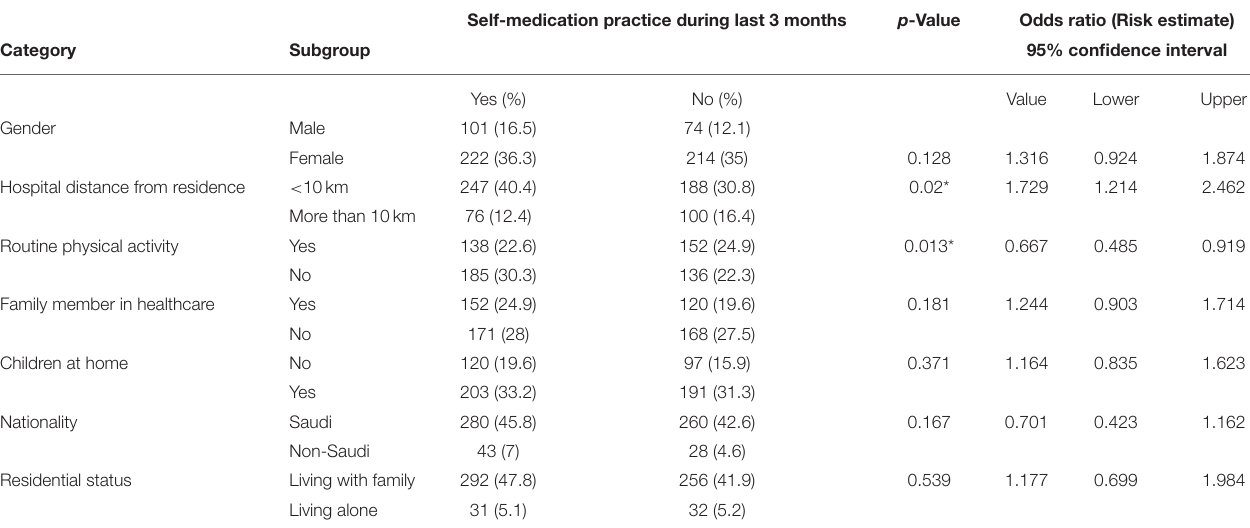
TABLE 4 | Factors influencing self-medication